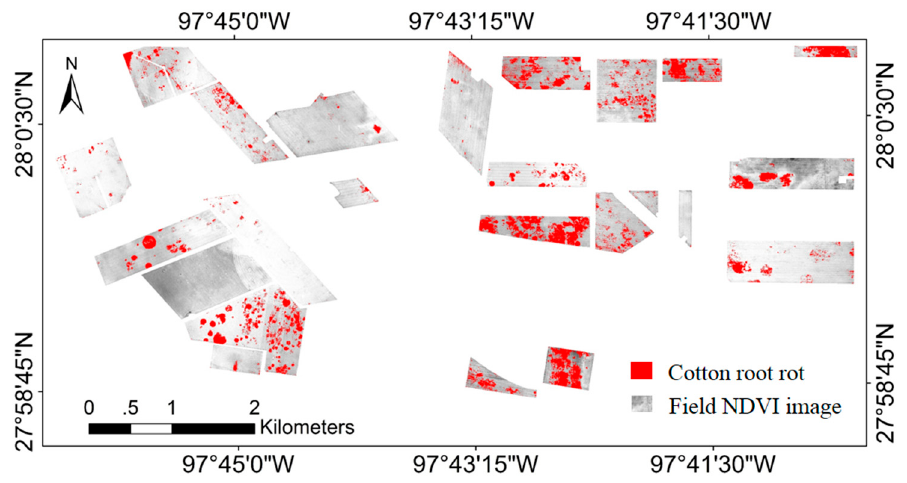
Figure 5. Classification maps based on field subset 0.81 m airborne images for 24 cotton fields. The red color within each field represents the root rot areas, while the gray color depicts non-infested areas. Table 1. Comparison of cotton root rot-infested areas for 24 cotton fields between the 0.81 m airborne image classification maps and resized 10 m classification map.